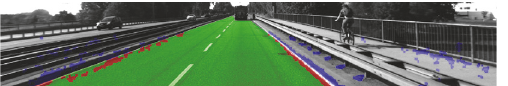
Figure 7: The road curb is not good feature for a road/nonroad classifier because half of the measurements are positive values of road and the others are not.